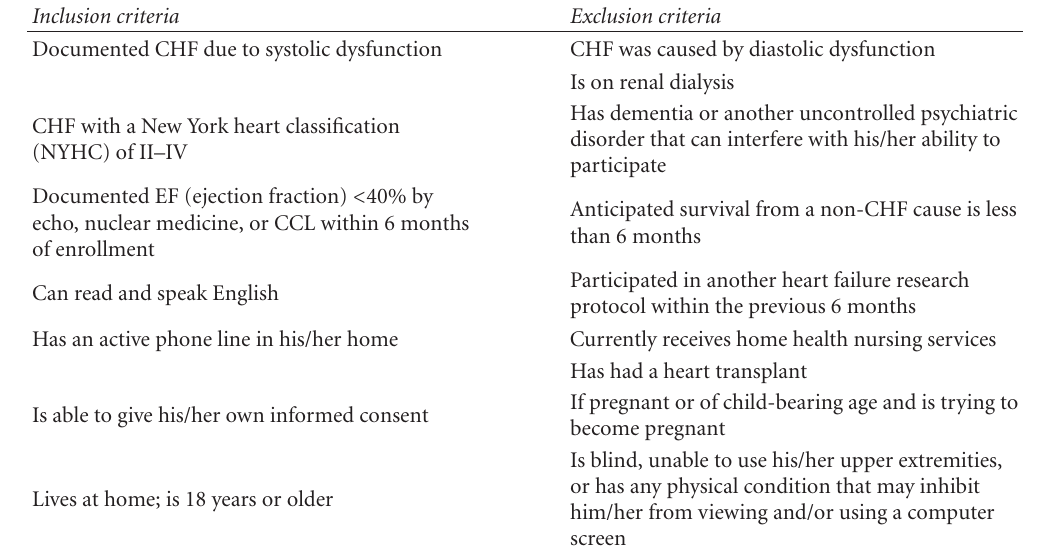
Table 1: Selection